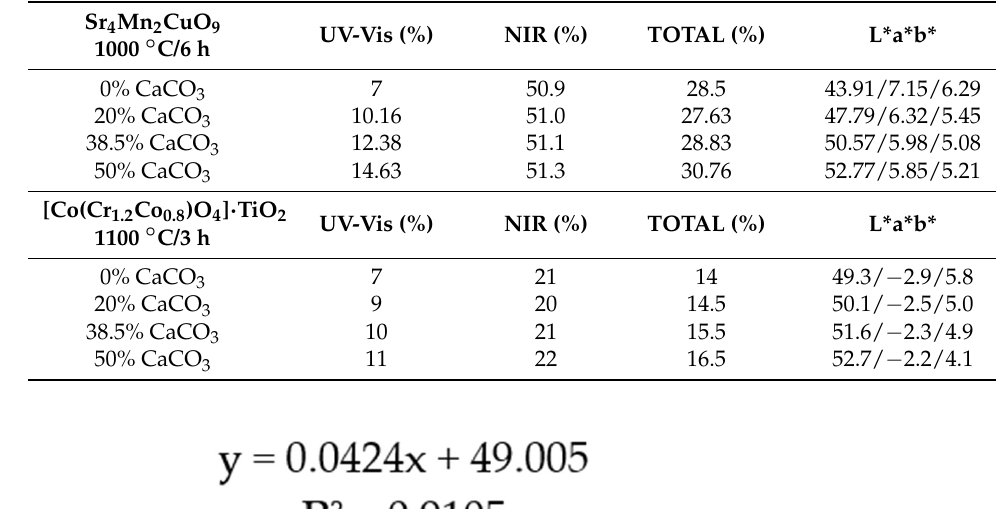
Table 5. Colorimetry and reflectance parameters for CaCO 3 addition to black pigments.